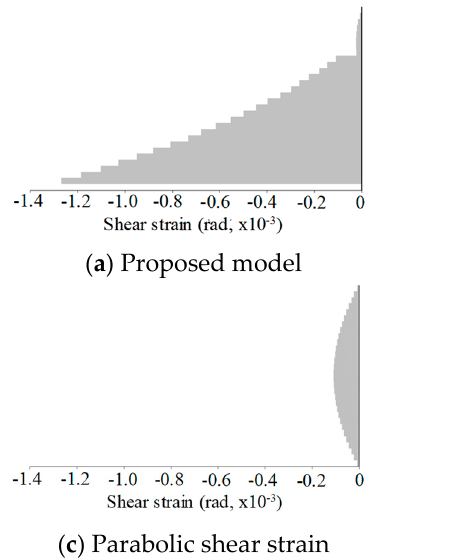
( b ) Constant shear flow ( c ) Parabolic shear strain ( d ) Constant shear strain Figure 12. Longitudinal strain distribution over the cross section (at critical section, 54.7 kN V =